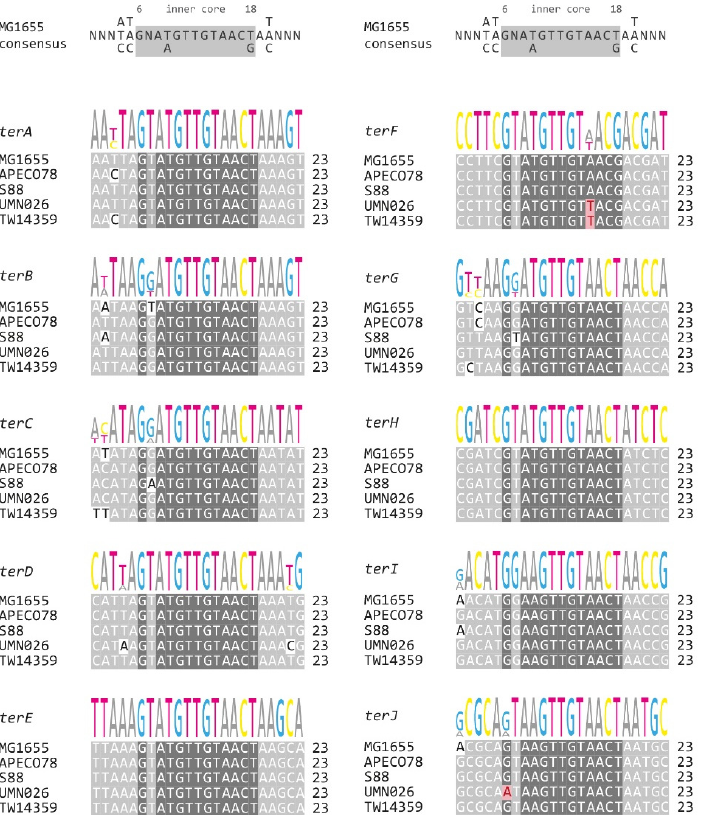
Figure 3. Sequence comparison of all ter sites from the 5 phylogroups in comparison to the MG1655 sequences. The ter consensus sequence derived from MG1655 is shown at the top. The phylogroups shown are A (MG1655), B1 (APEC078), B2 (S88), D (UMN026) and E (TW14359). Base pairs 1–5, 7 and 19–23 show a high degree of variability and are shaded in a lighter grey. The highly conserved core (6, 8–18) is highlighted by a darker grey. Mismatches unlikely to interfere significantly with binding have a white background shading. Mismatches within the core conserved sequence that are likely to interfere with binding are highlighted in red. Relative nucleotide frequencies are shown above as scaled letters.